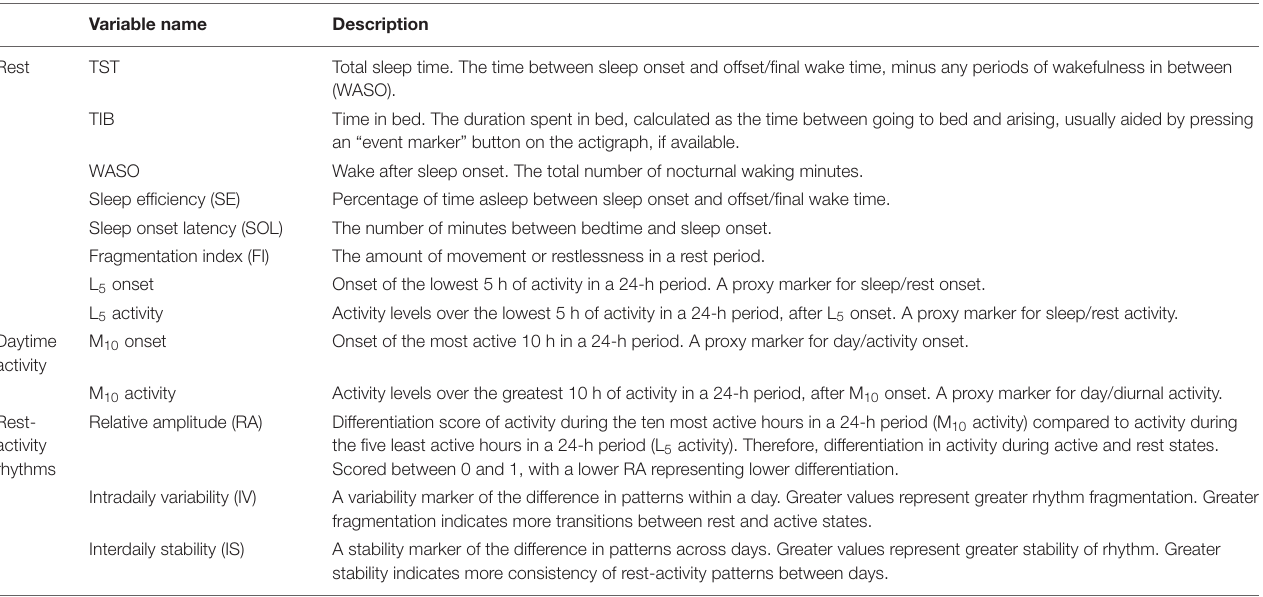
TABLE 1 | Overview of commonly used actigraphy